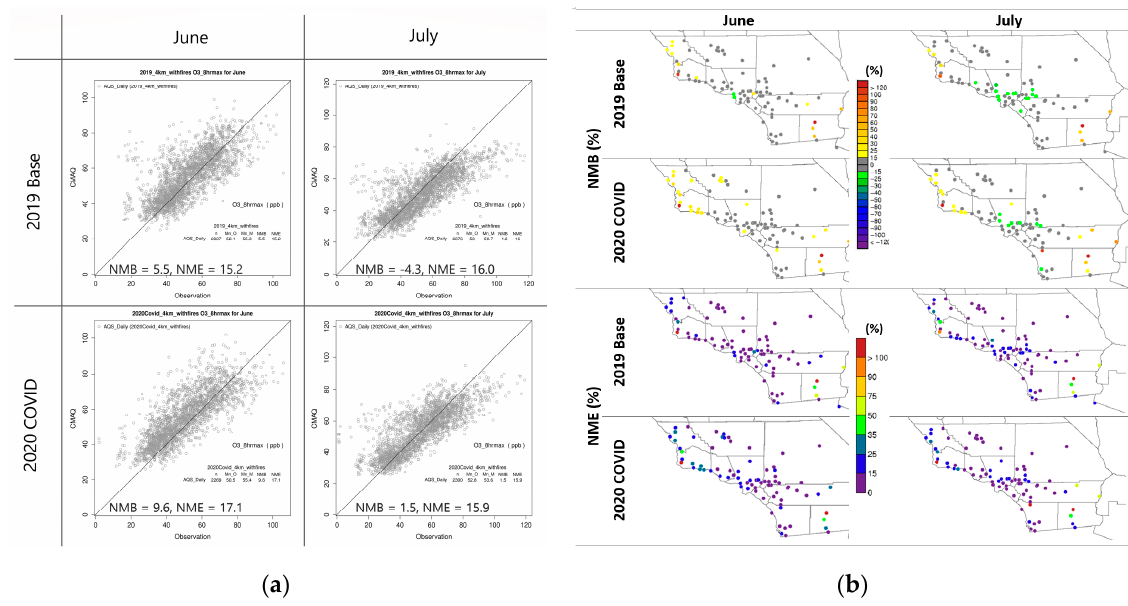
Figure 5. MDA8 ozone performance plots: ( a ) Scatter plots; ( b ) Spatial plots of NMB and